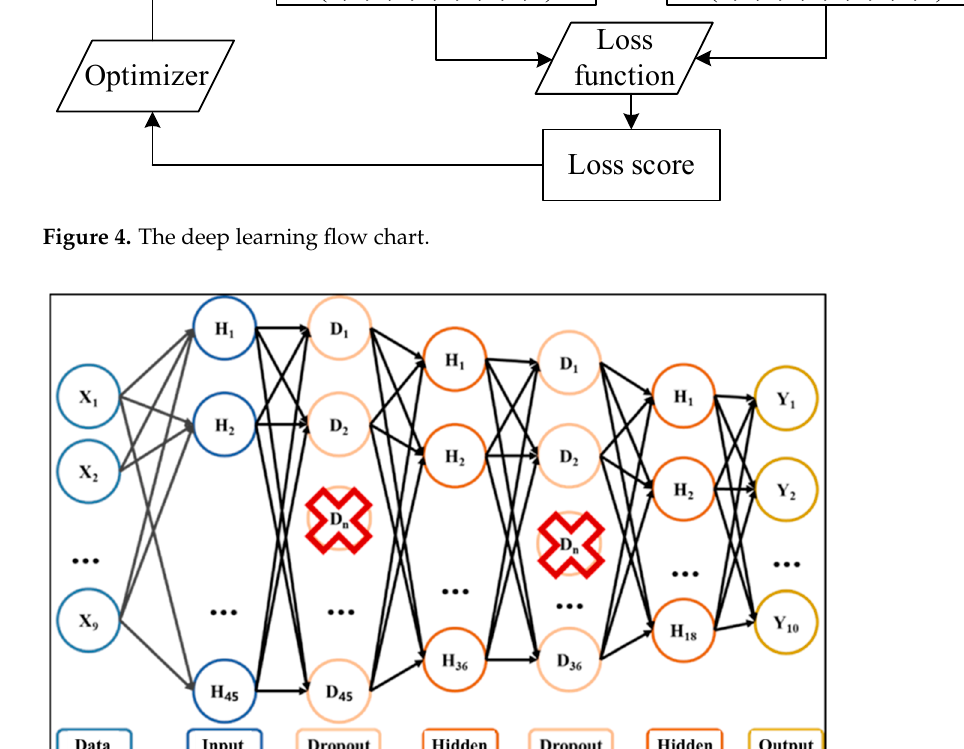
Figure 5. Prediction model of the neural network.